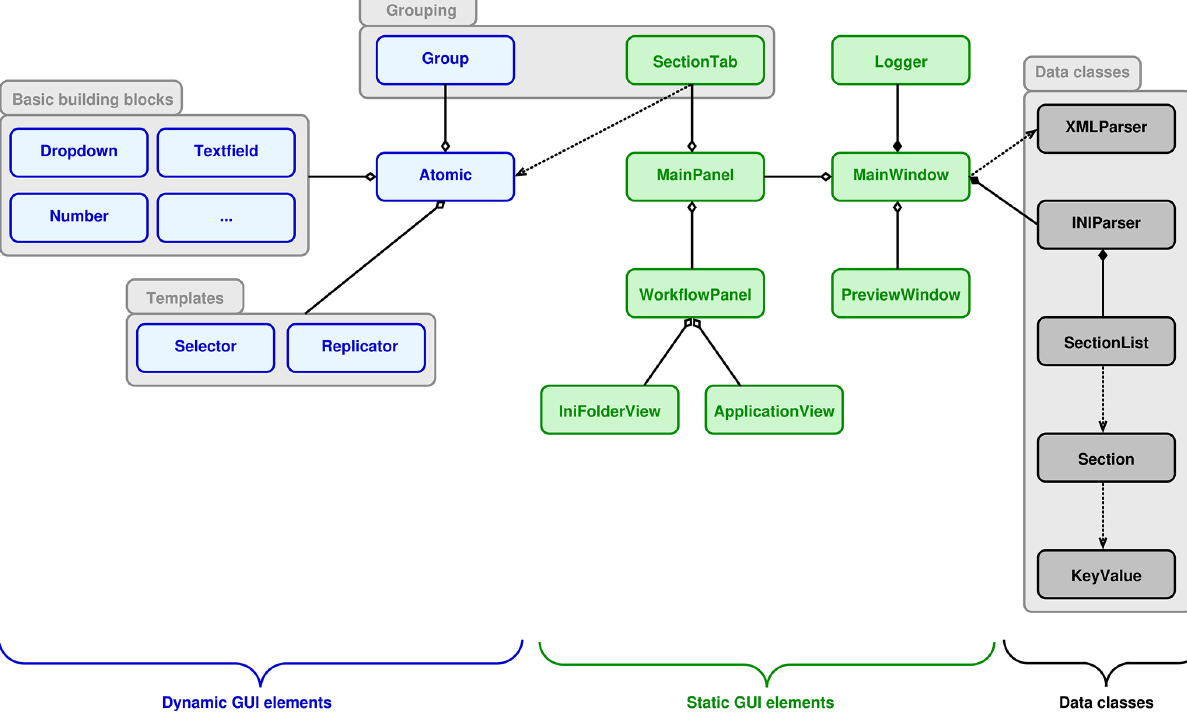
Figure 5. Simplified class diagram of Inishell: only the most relevant classes and relations have been represented. The classes shown in green show a set of static widgets in the GUI, the classes shown in blue are used to dynamically build widgets (based on the XML file), and the classes shown in black do not draw in the